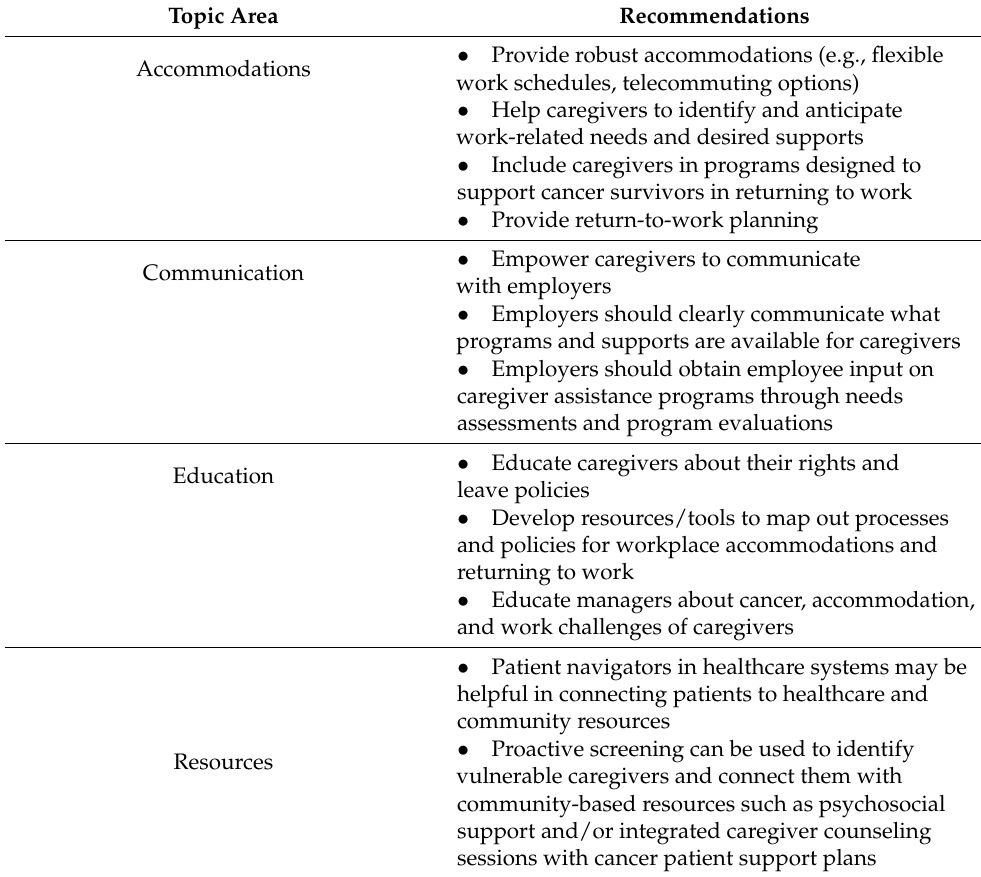
Table 2. Practice